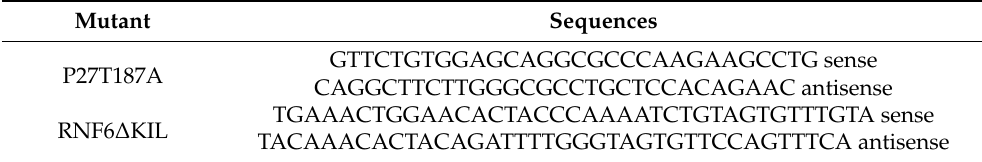
Table 1. List of primers used for mutagenesis